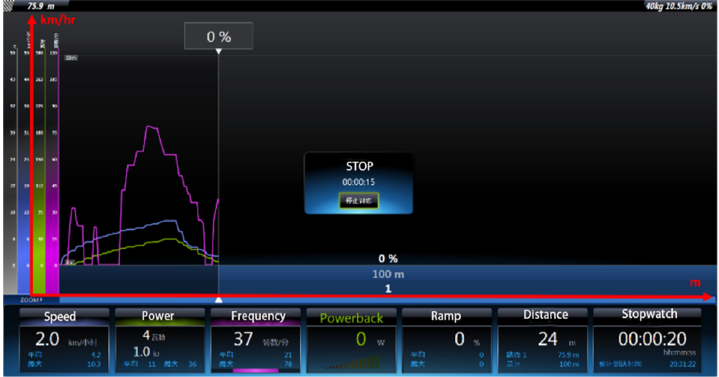
Figure 18. Results for flat road, cyclist weight 40 kg, and electromagnetic reversal braking.